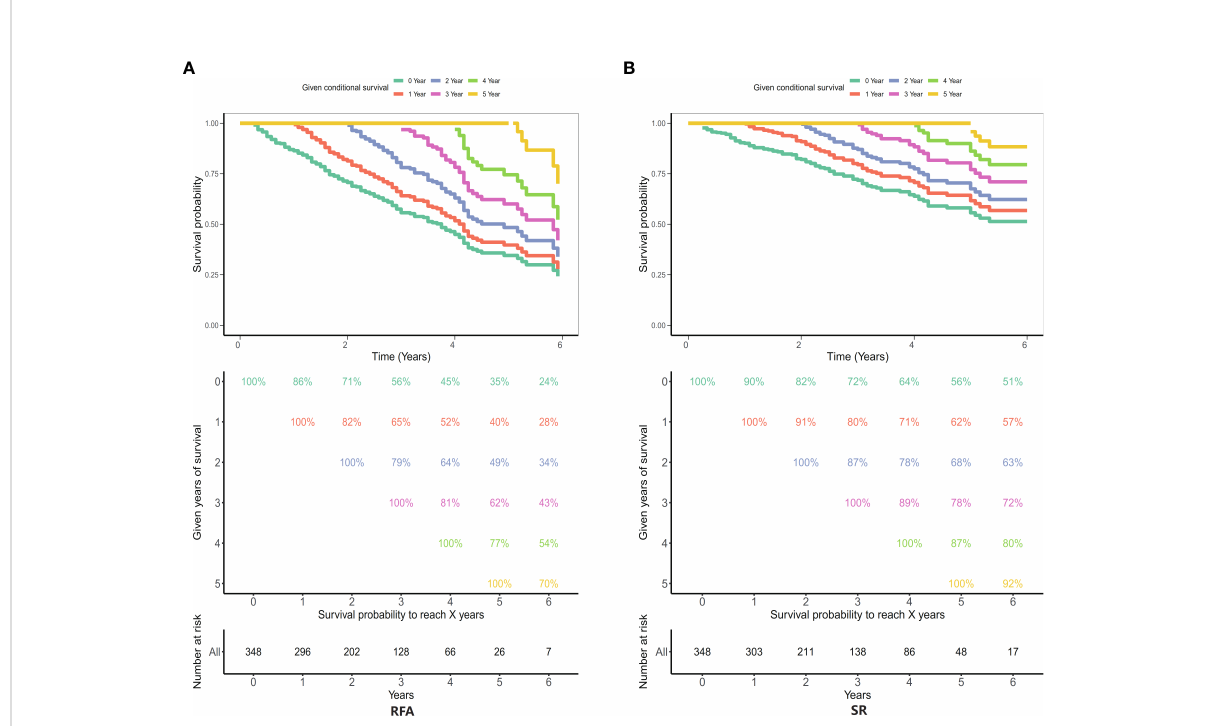
FIGURE 9 Five-year survival rates in the radiofrequency therapy group and the conventional surgery group. (A) Radiofrequency ablation (RFA) group; (B) Surgical resection (SR) group.